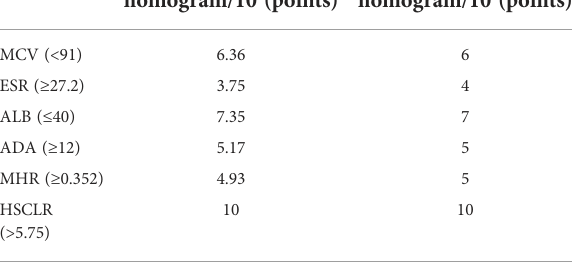
TABLE 3 A scoring system developed from a nomogram of the training set. Parameters Score generated from nomogram/10